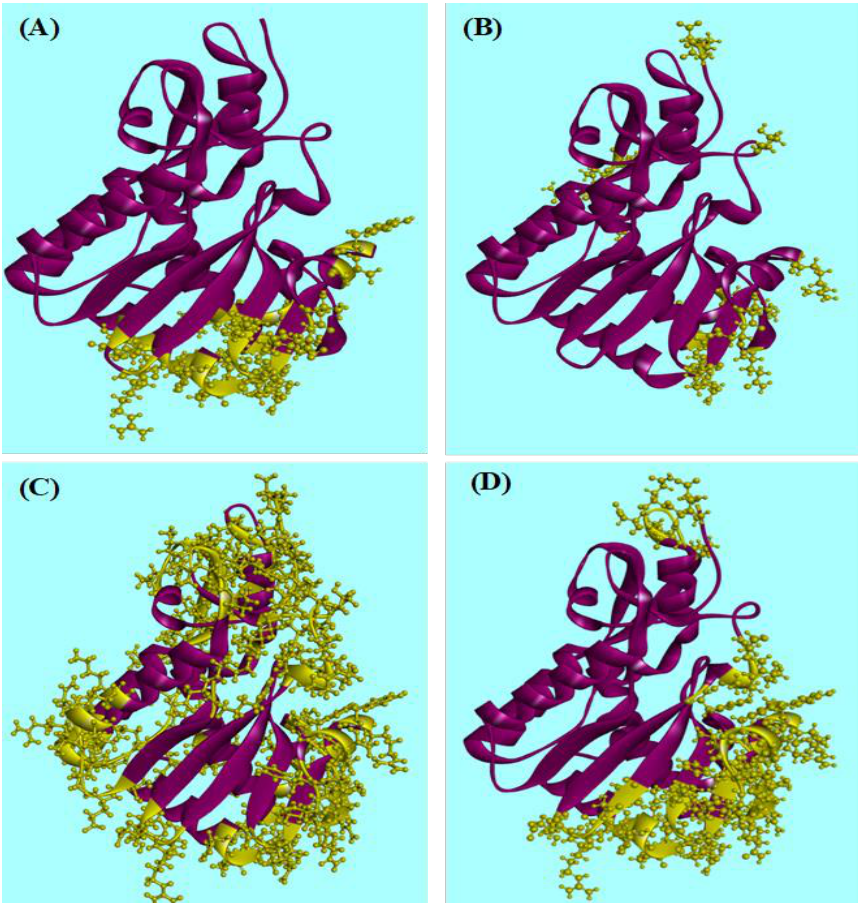
Figure 3. Conformational B-cell PAC epitopes prediction ( A ) EPSVR server, and ( B ) DiscoTope server, ( C ) Ellipro server ( D ) SEPPA server. Yellow ball and stick shapes display high immunogen spots.